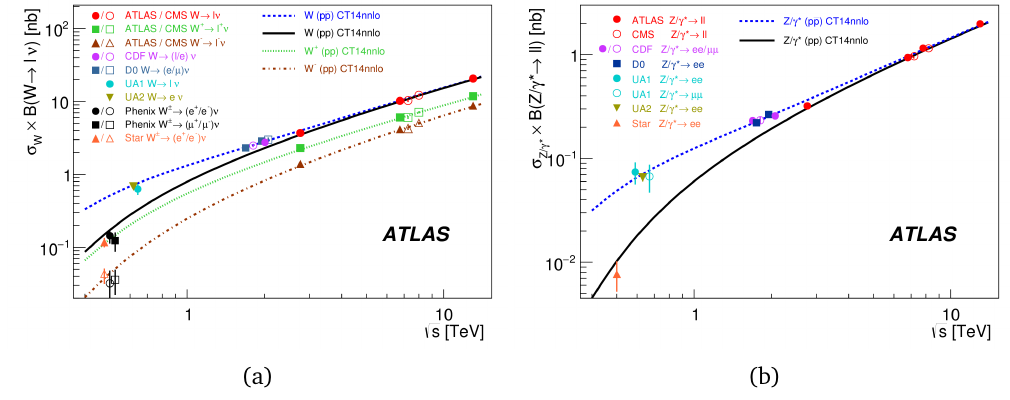
× B ( W → l ν ) and (b) σ × B ( Z /γ ∗ → ll ) W Z /γ ∗